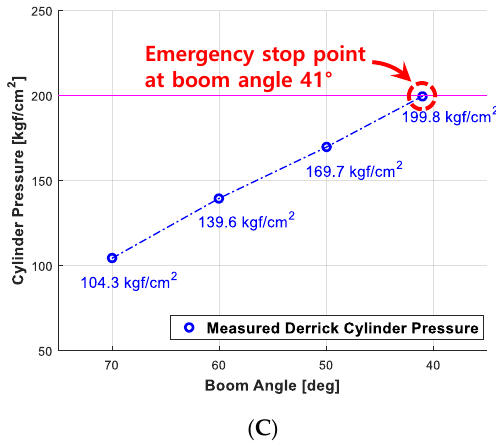
Figure 19. Experiment outputs obtained when controlling boom angle and derrick cylinder pressure in each wind speed. ( A ) 1~2 m/s; ( B ) 3~4 m/s; ( C ) 5~6 m/s.